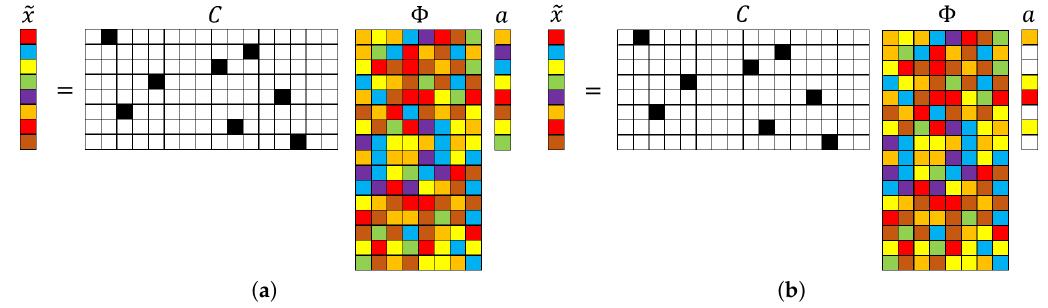
Figure 1. Schematic illustration of l 2 ( a ) and l 1 ( b ) minimization reconstruction for sparse recovery using a single-pixel measurement matrix. The numerical values in C are represented by colors: black (1), white (0). The other colors represent numbers that are neither 0 nor 1. In the above schematics ˜ x ∈ R P , C ∈ R P × N , Φ ∈ R N × N b and a ∈ R N b , where N b ≤ N . The number of colored cells in a represents the system sparsity K . K = N b for l 2 and K < N b for l 1